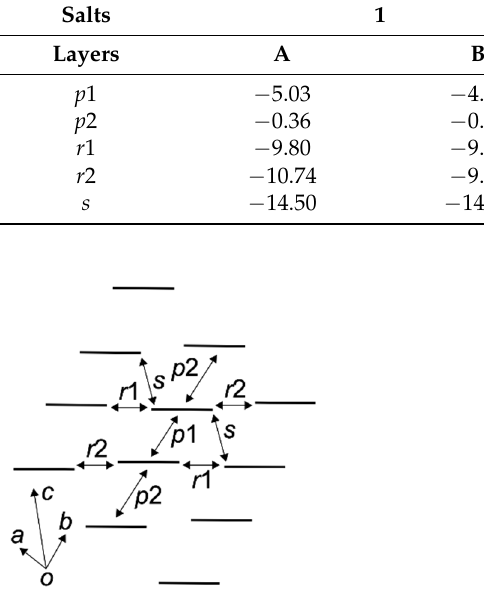
Figure 6. Schematic diagram of the structure of the donor layer with directions of interactions of 1 and 2 .